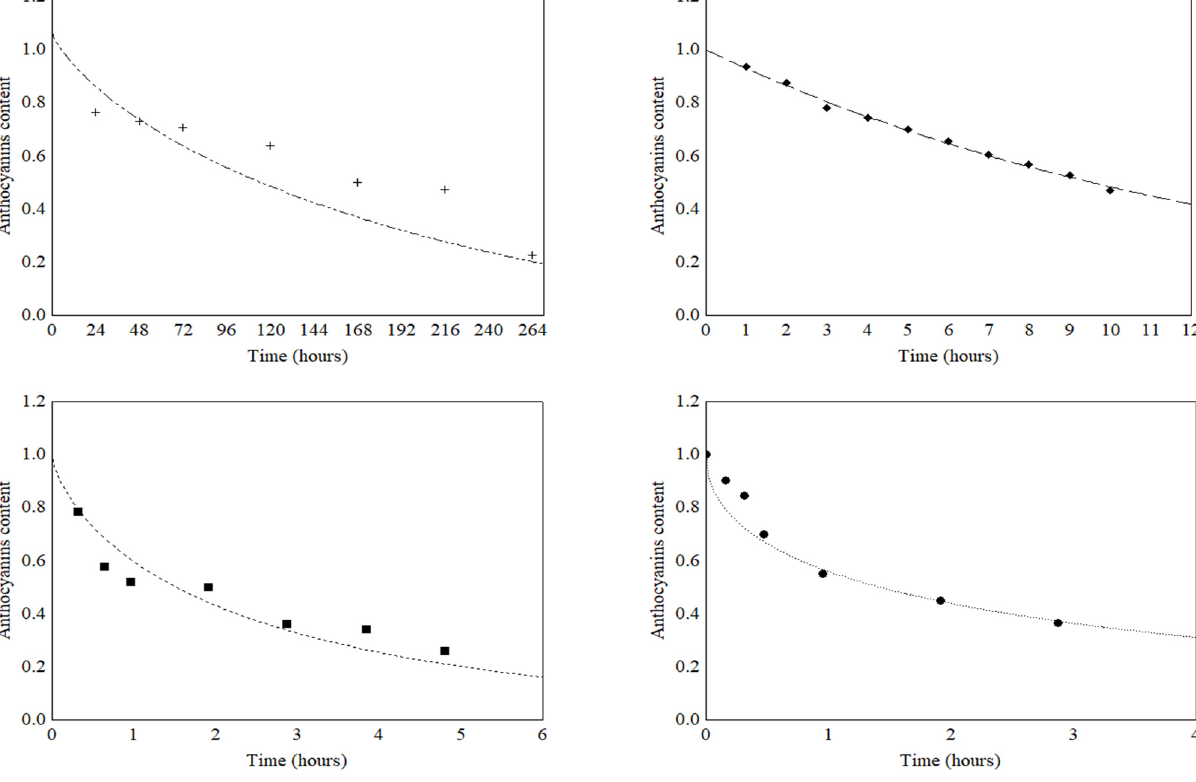
Figure 2. Weibull model fitted to the thermal degradation data of anthocyanins in grumixama extracts. (+) 30 ◦ C; ( (cid:117) ) 60 ◦ C; ( (cid:4) ) 80 ◦ C; ( • ) 100 ◦ C. Table 3. Parameters of mathematical modeling and kinetic parameters of thermal degradation of anthocyanins in grumixama extracts obtained by the Weibull